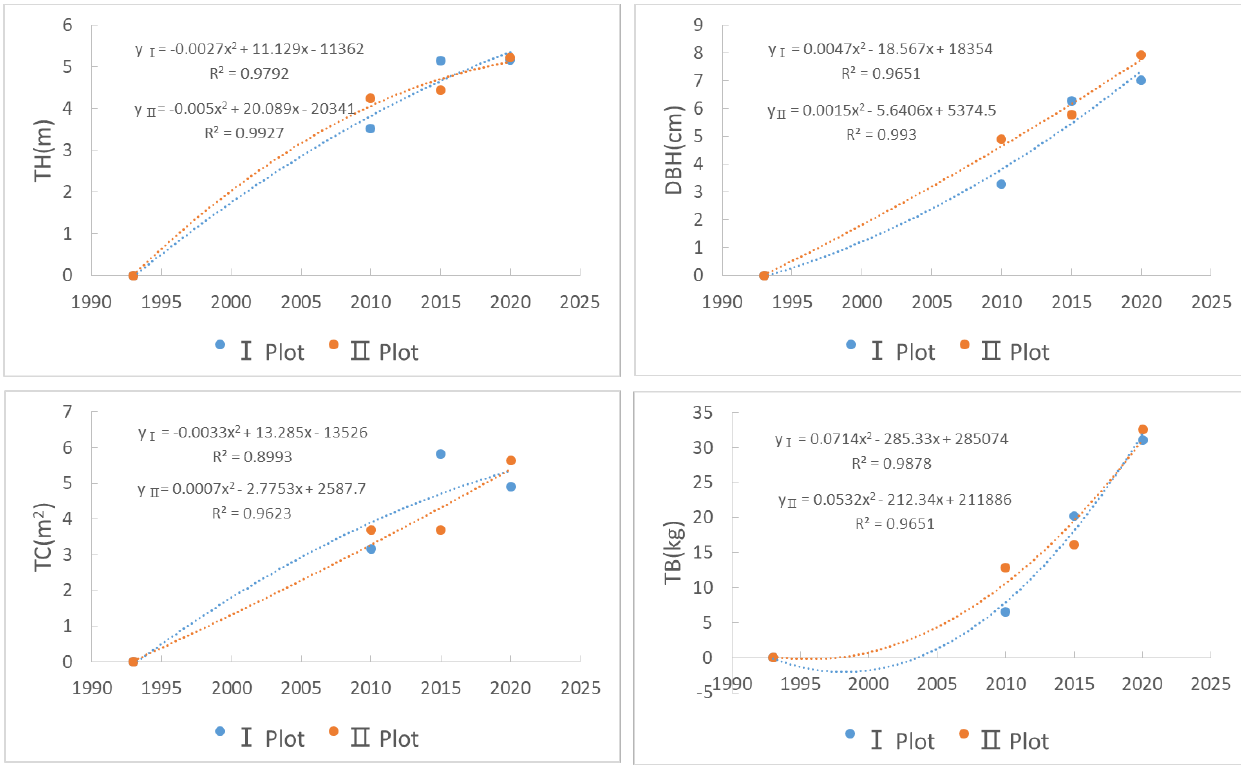
Figure 6. Vegetation index dynamics.